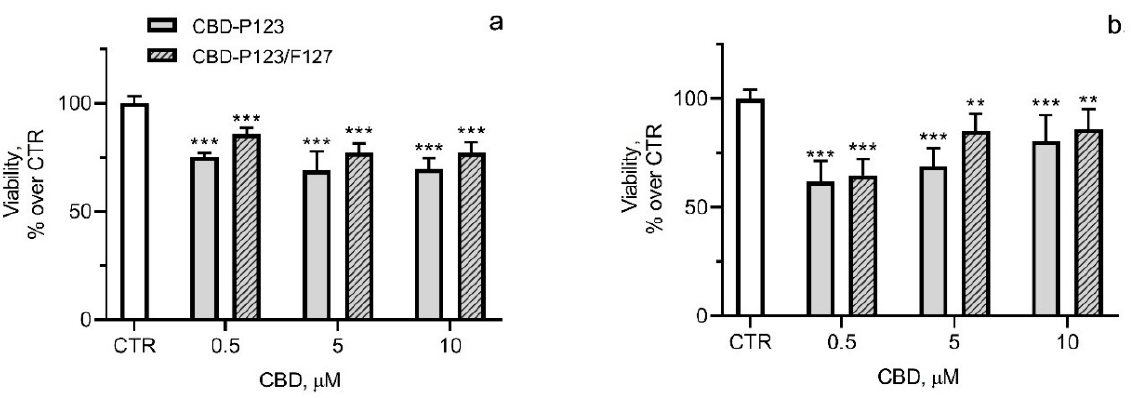
Figure 8. Effects on cell viability after 72 h of treatment of SH-SY5Y cells ( a ) and Neuro-2a cells ( b )